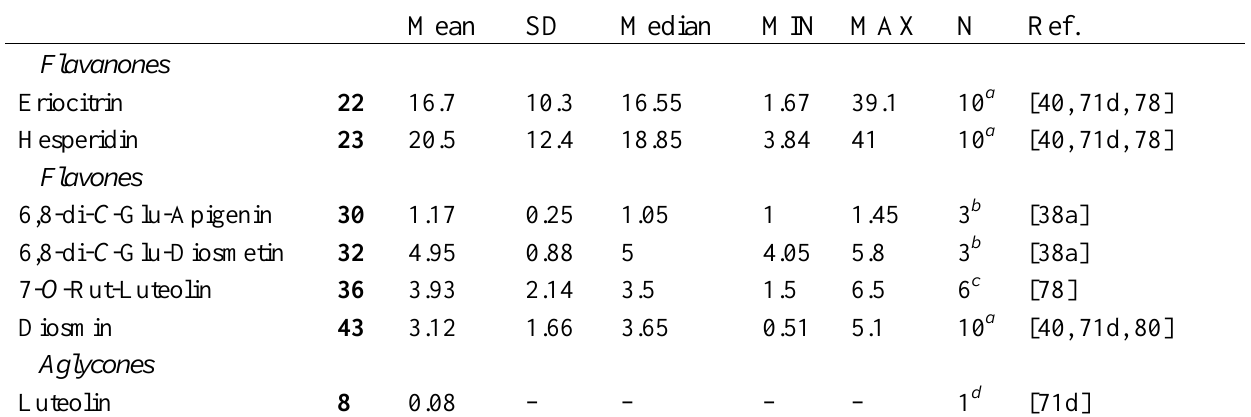
Table 12 . Flavonoid composition of C. limon juice (mg/100 mL).